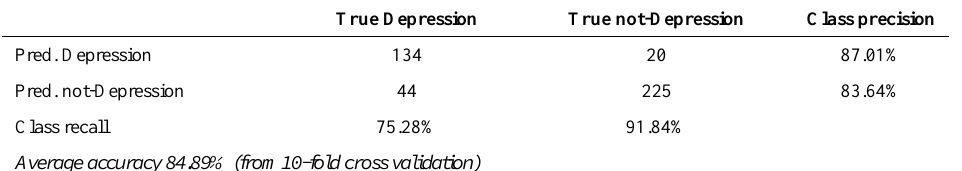
Table 5. The accuracy, precision, and recall of depression prediction model using all trauma items with random forest classifier True Depression